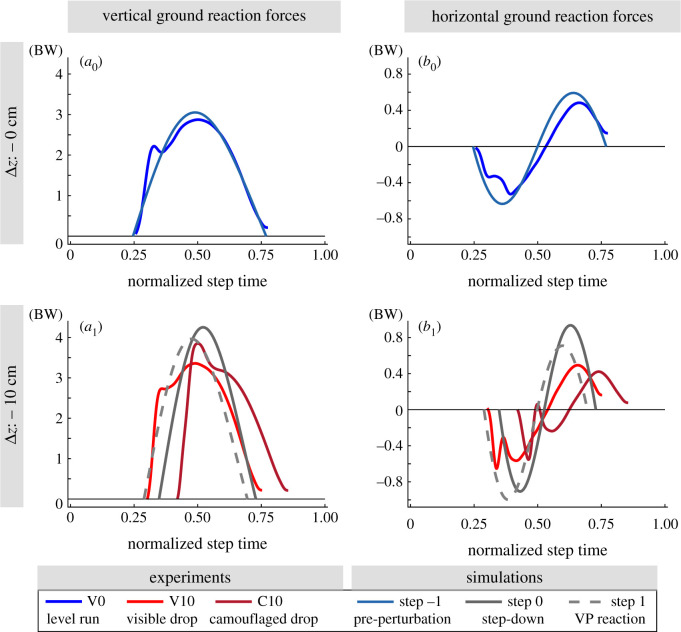
The vertical (a) and horizontal (b) ground reaction forces (GRFs) are plotted over normalized step time. The mean of the experimental results are shown. The TSLIP model simulation is able to capture the characteristics of the GRF in level running (a0, b0). For the step-down perturbation, the model predicts higher values for the peak vertical (a1) and horizontal (b1) GRF, compered to the mean values of the experiments.